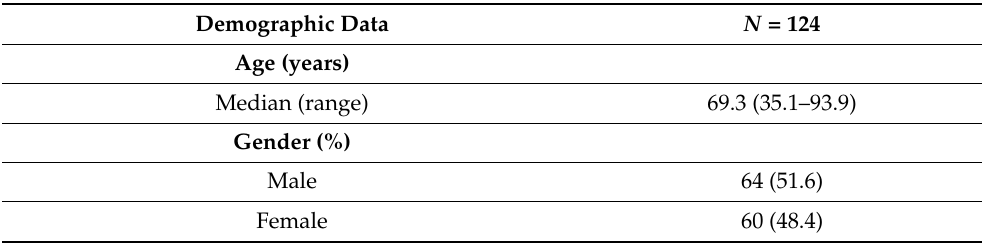
Table 1. Demographic data of the 124 cohort patients. ECOG = European Collaborative Oncology Group performance status